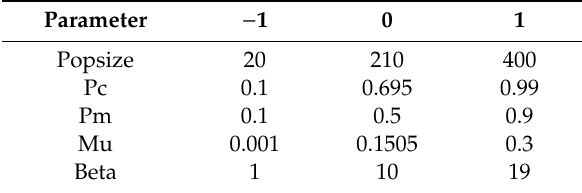
Table 4. The genetic algorithm (GA) parameters and their respective